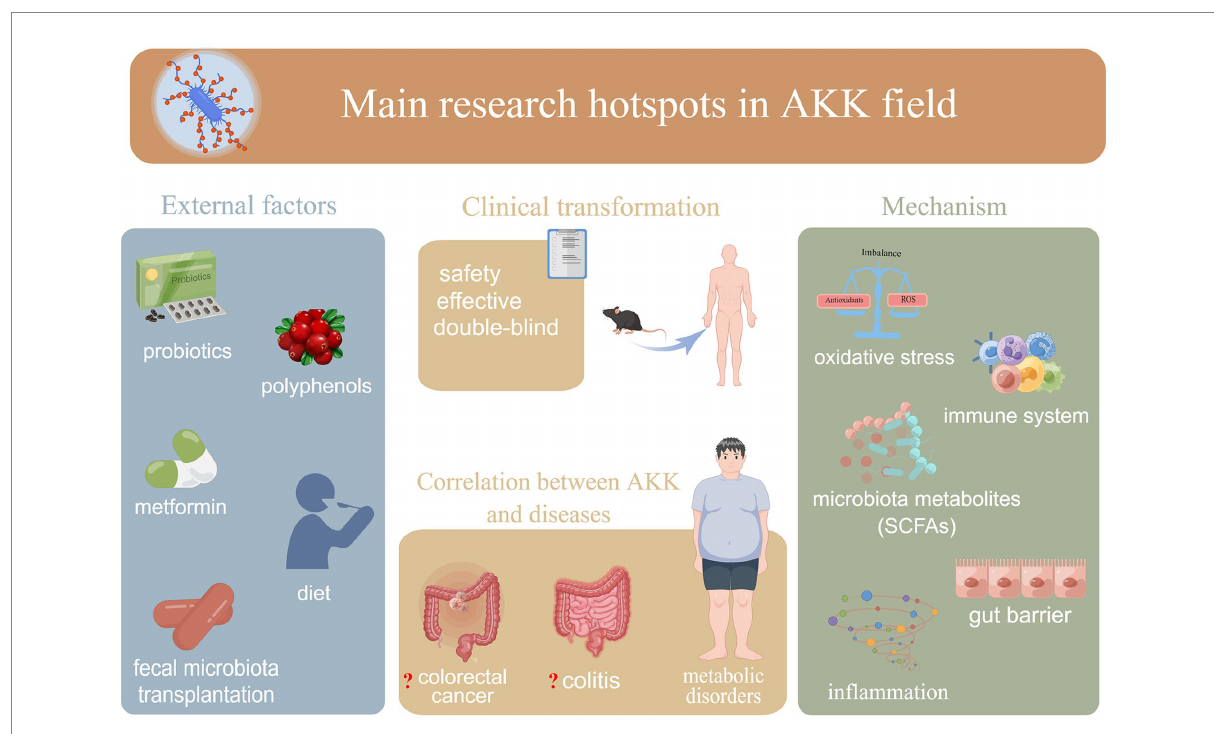
FIGURE 2 Recent hotspot directions of A. muciniphila research: (i) external factors affecting A. muciniphila; (ii) mechanisms underlying the association between A. muciniphila and hosts (including bacteria); (iii) correlations between A. muciniphila and different diseases; (iv) safety and efficacy of clinical use of A. muciniphila. AKK: A. muciniphila